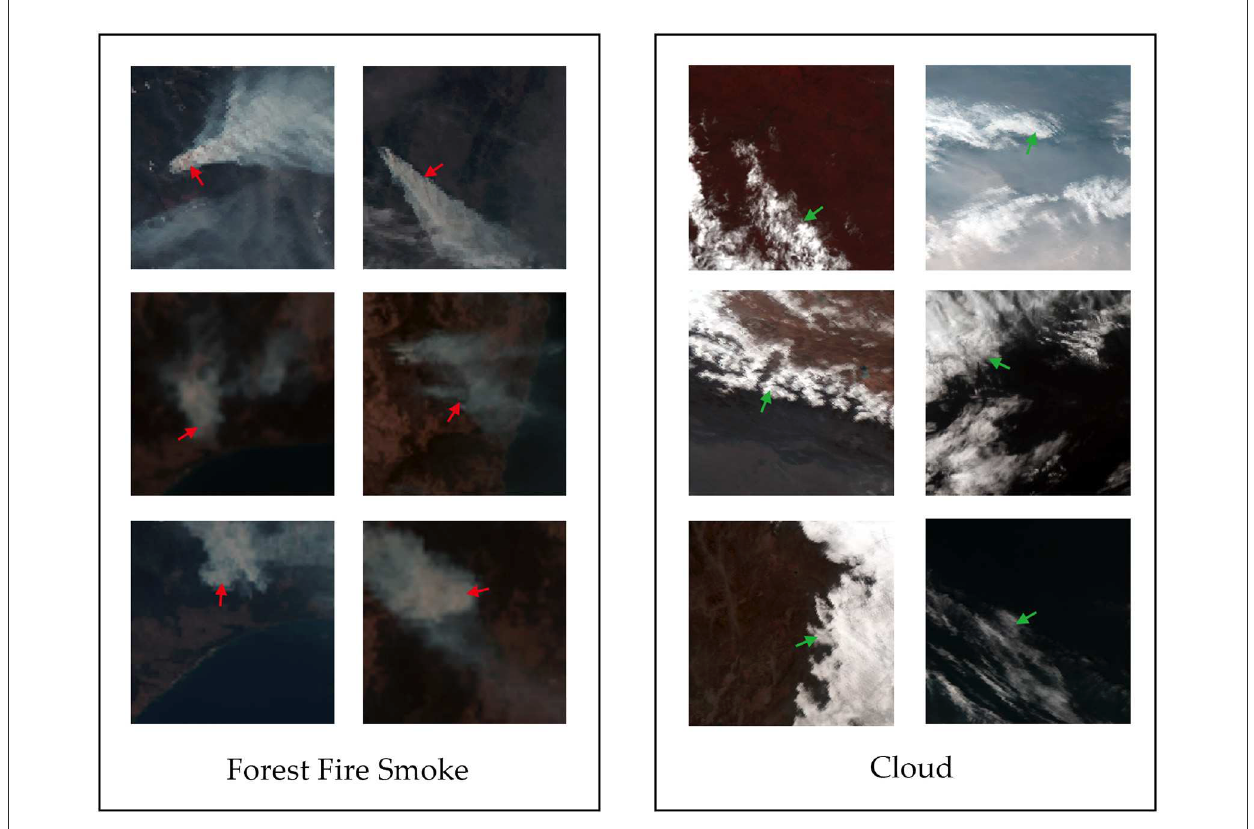
FIGURE2 Example remote sensing sample images of cloud (marked with green arrow) and forest fire smoke (marked with red arrow).